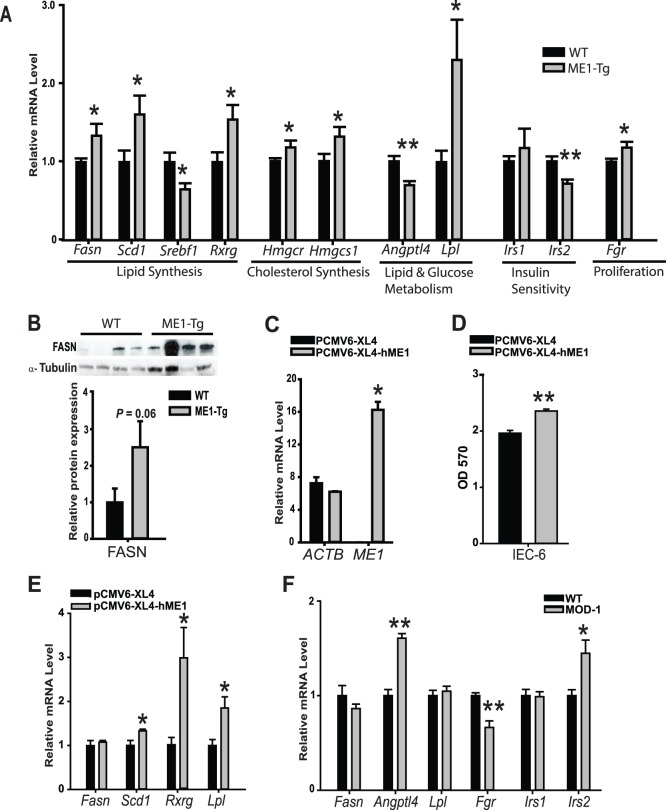
Enhanced intestinal ME1 expression with HF diet induces jejunum lipogenic- and proliferation-associated gene expression.A) Relative expression of jejunum genes of WT and ME1-Tg mice [Exp. 2 (n = 7−9/group)]. B) Western blot and corresponding band densitometry analysis of FASN in the jejunum of WT and ME1-Tg mice (Exp. 2). C–E) Effects of ME1 over-expression on intestinal epithelial cell proliferation and gene expression in vitro. Rat intestinal epithelial cells (IEC-6) were transfected with control or hME1 expression vectors; overexpression of human ME1 mRNA, but not beta-actin mRNA, was observed by RT-PCR (C). At 48 h, cells were evaluated for proliferation by MTT assay (D), and at 96 h (E) evaluated for expression of Fasn, Scd1, Rxrg and Lpl genes (n = 3 replicates/group). F) Gene expression of Fasn, Angptl4, Lpl, Fgr, Irs1 and Irs2 in jejunums of WT and MOD-1 mice fed HF diet (n = 5/group). RT-PCR was repeated twice in all experiments, and MTT proliferation assay was repeated thrice. Bar graphs represent mean ± SEM. Significant differences at *P<0.05 and ** P<0.01 between genotypes.